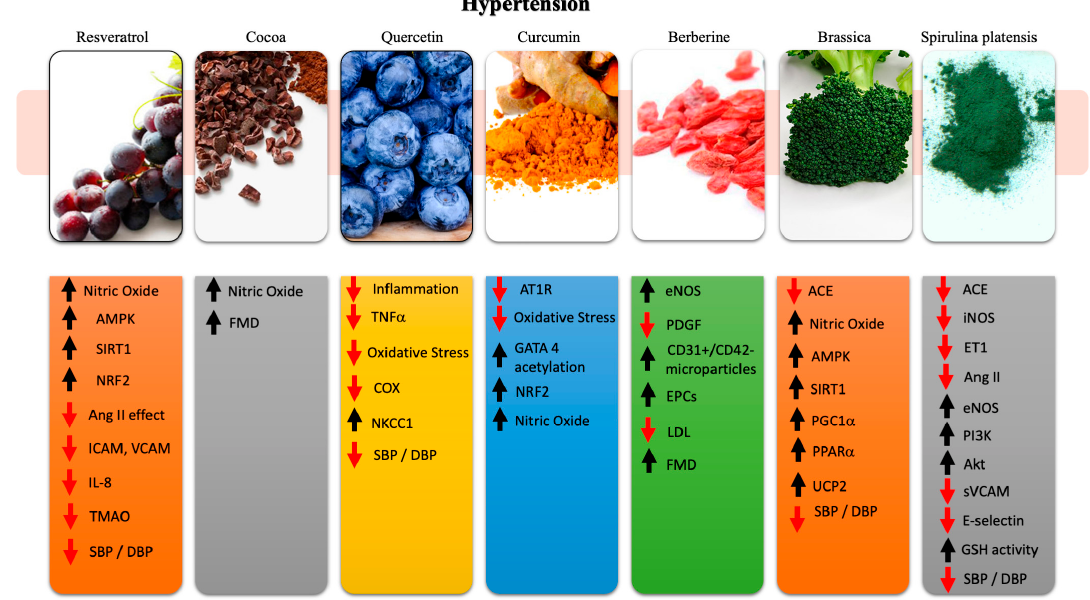
Figure 1. Summary of the main molecular and physiological e ff ects exerted by resveratrol, cocoa, quercetin, curcumin, brassica, berberine, and Spirulina platensis in hypertension. Red arrow ( ↓ ) indicates downregulation; black arrow ( ↑ ) indicates upregulation.